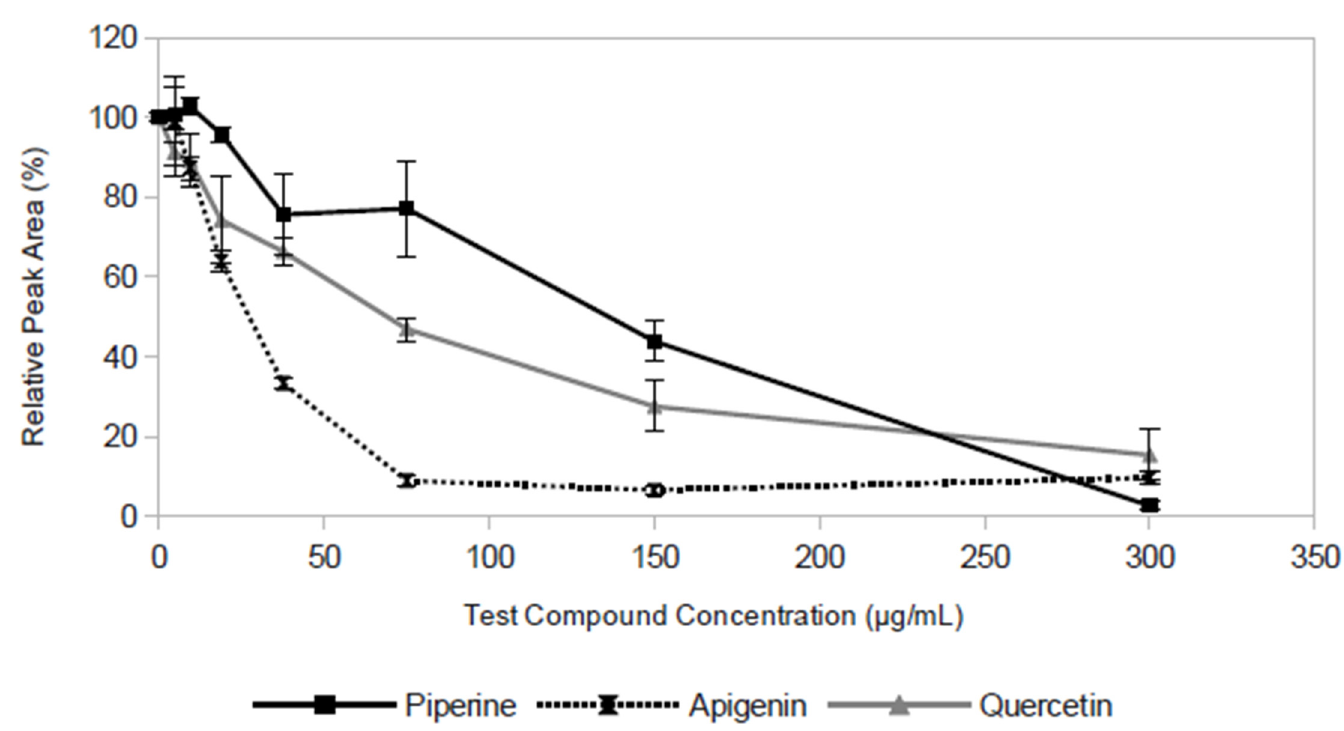
Fig 4. Efflux pump inhibitory activity of apigenin, piperine, and quercetin as indicated by LC-MS measurement of residual ethidium bromide in spent broth after a 30 min incubation. Relative peak area (expressed as a percentage) for ethidium is plotted as a function of concentration of the putative inhibitor. Data points represent the mean of 3 measurements (biological replicates), with error bars representing standard